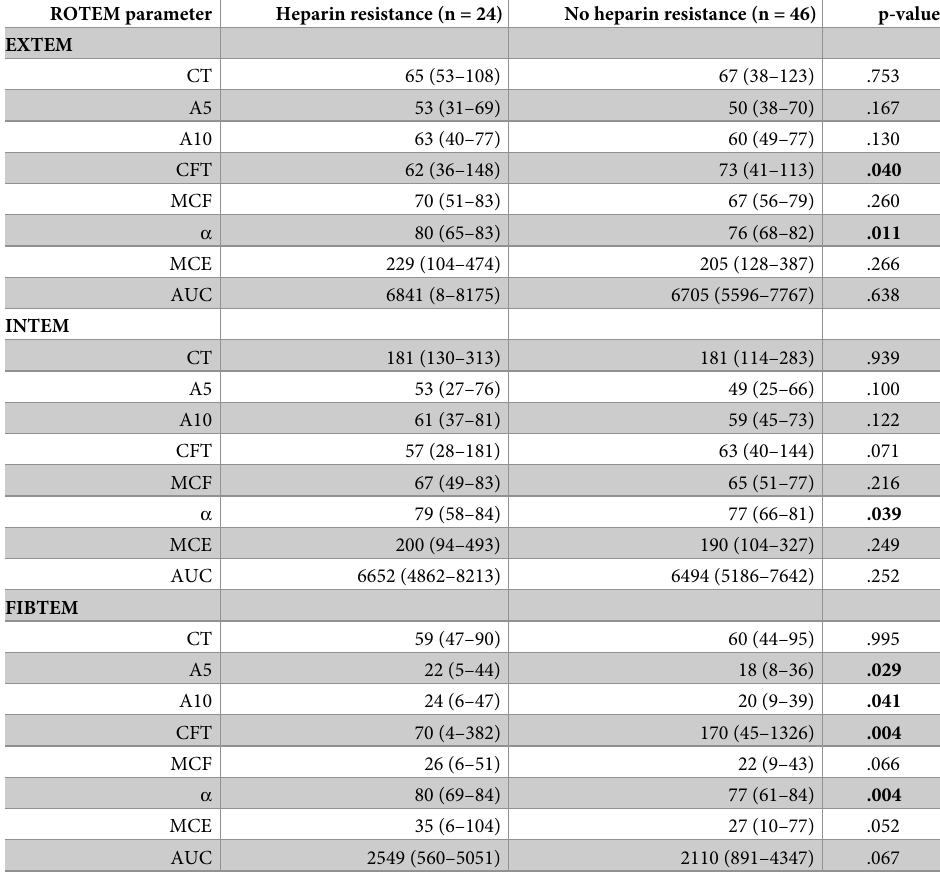
Table 5. Preoperative ROTEM values in patients with and without heparin resistance.